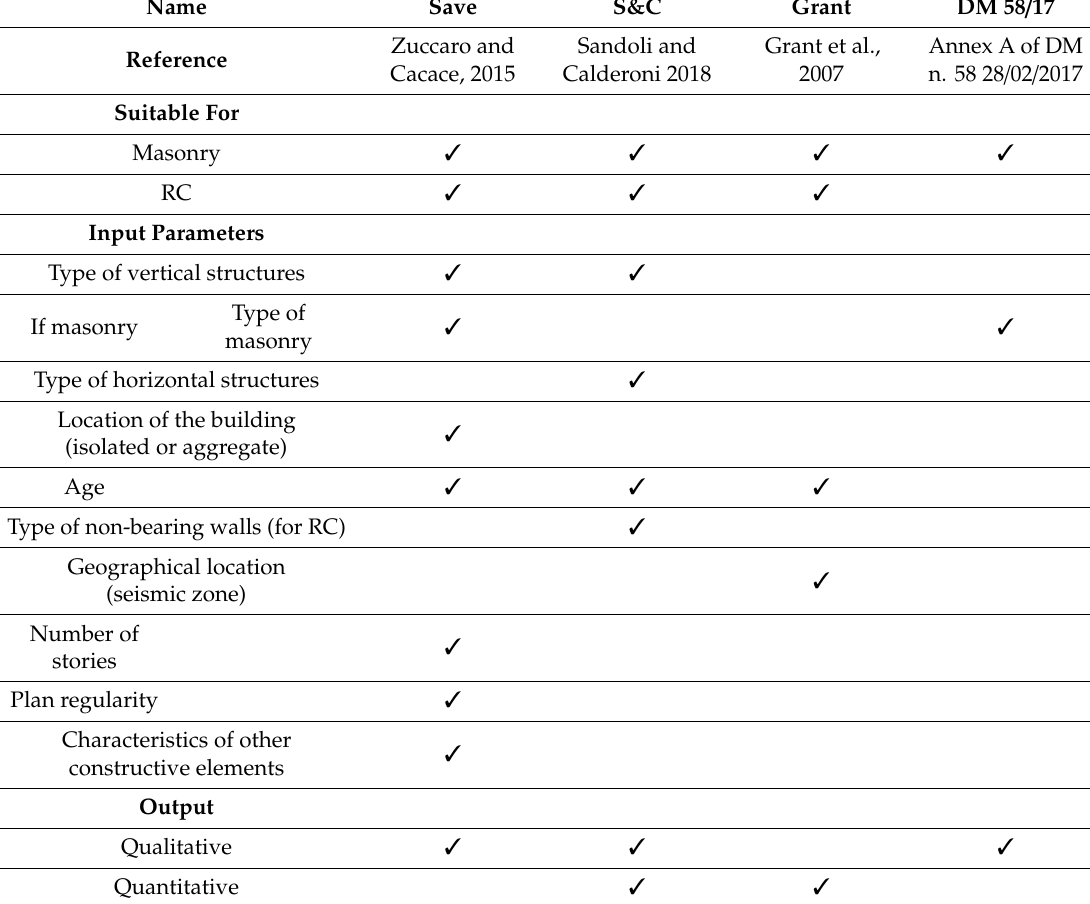
Table 1. Summary of simplified approaches belonging to Group